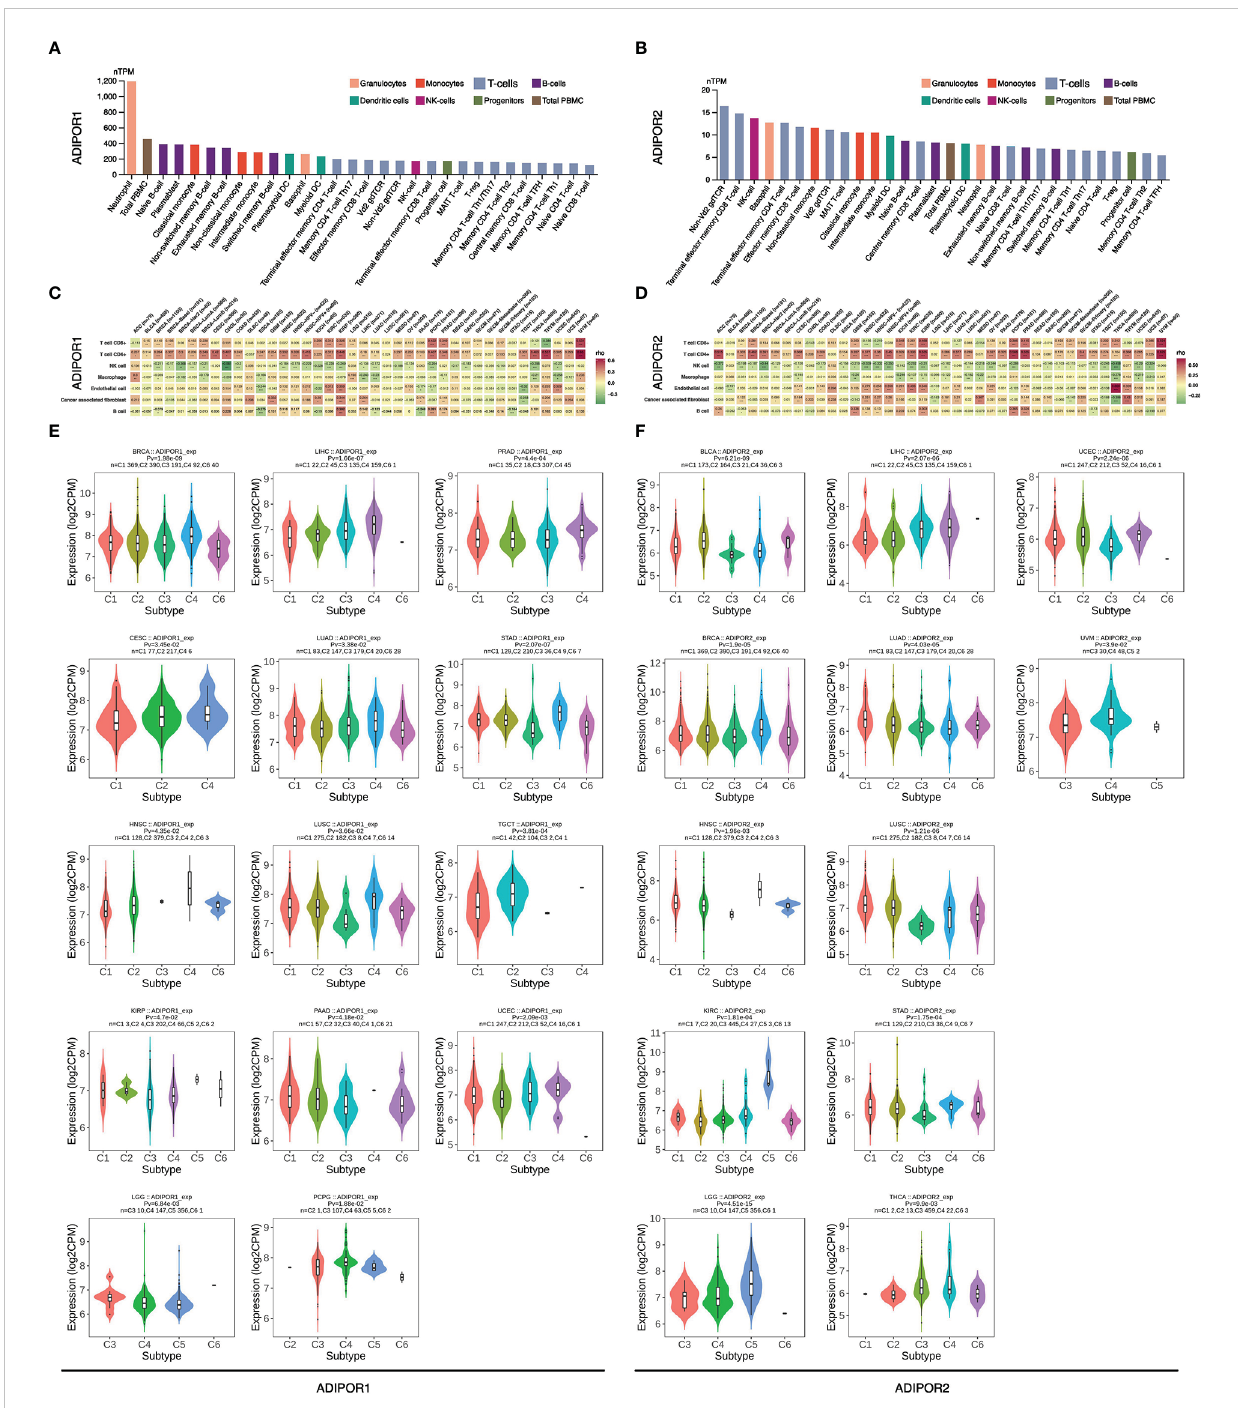
FIGURE 6 The correlation of ADIPOR1/2 with tumor immune microenvironment. (A, B) The expression of ADIPOR1/2 in immune cells. (C, D) The correlation between ADIPOR1/2 and tumor microenvironment. (E, F) The distribution of ADIPOR1/2 in immune subtypes of